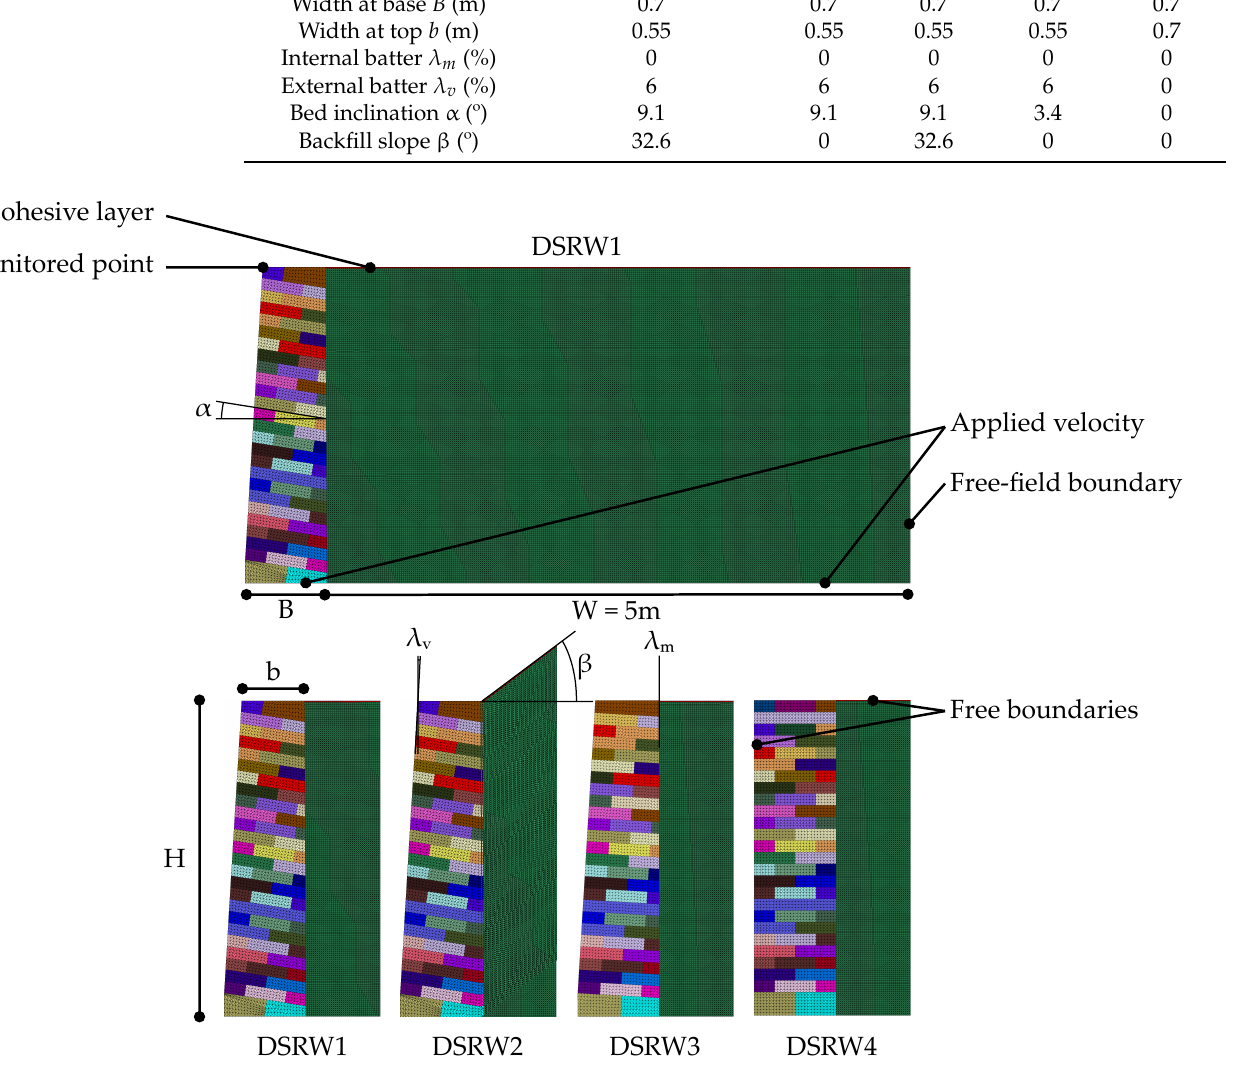
Figure 9. Zoom images of the geometrical models for the numerical simulations of full-scale DSRWs. The geometrical parameters are also depicted. The original case study “C3s” corresponds to